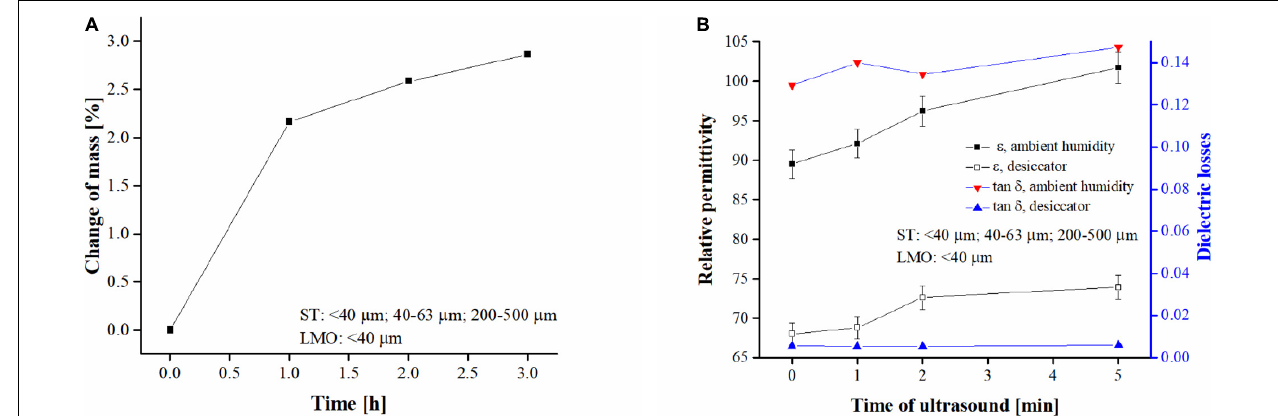
FIGURE 6 | LMO-ST composites exposed to different conditions. (A) LMO-ST samples were exposed to 100% humidity, and the change in mass over time was observed. (B) Comparison of ε r and tan δ values measured in ambient humidity (60% RH) and desiccator as a function of varied time of ultrasonic treatment.